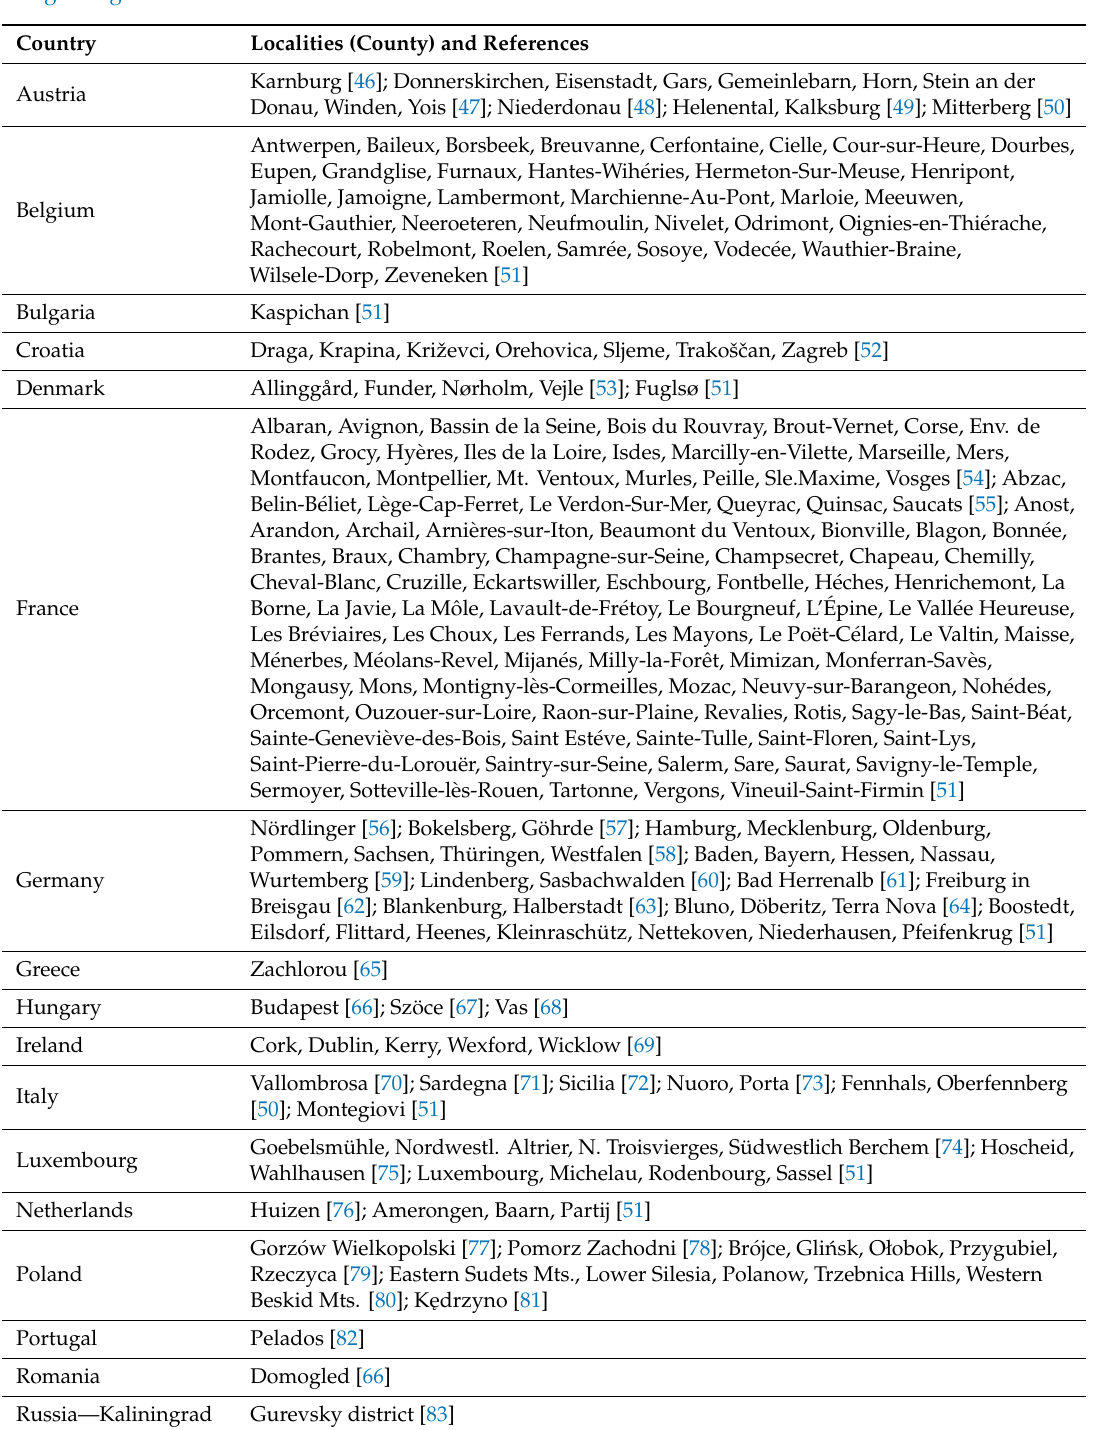
Table 1. Known localities of Phloeotribus rhododactylus in Europe. Data and localities are summarized based on the literature available from Google Scholar, Zobodat, Biodiversity Heritage Library, and www.